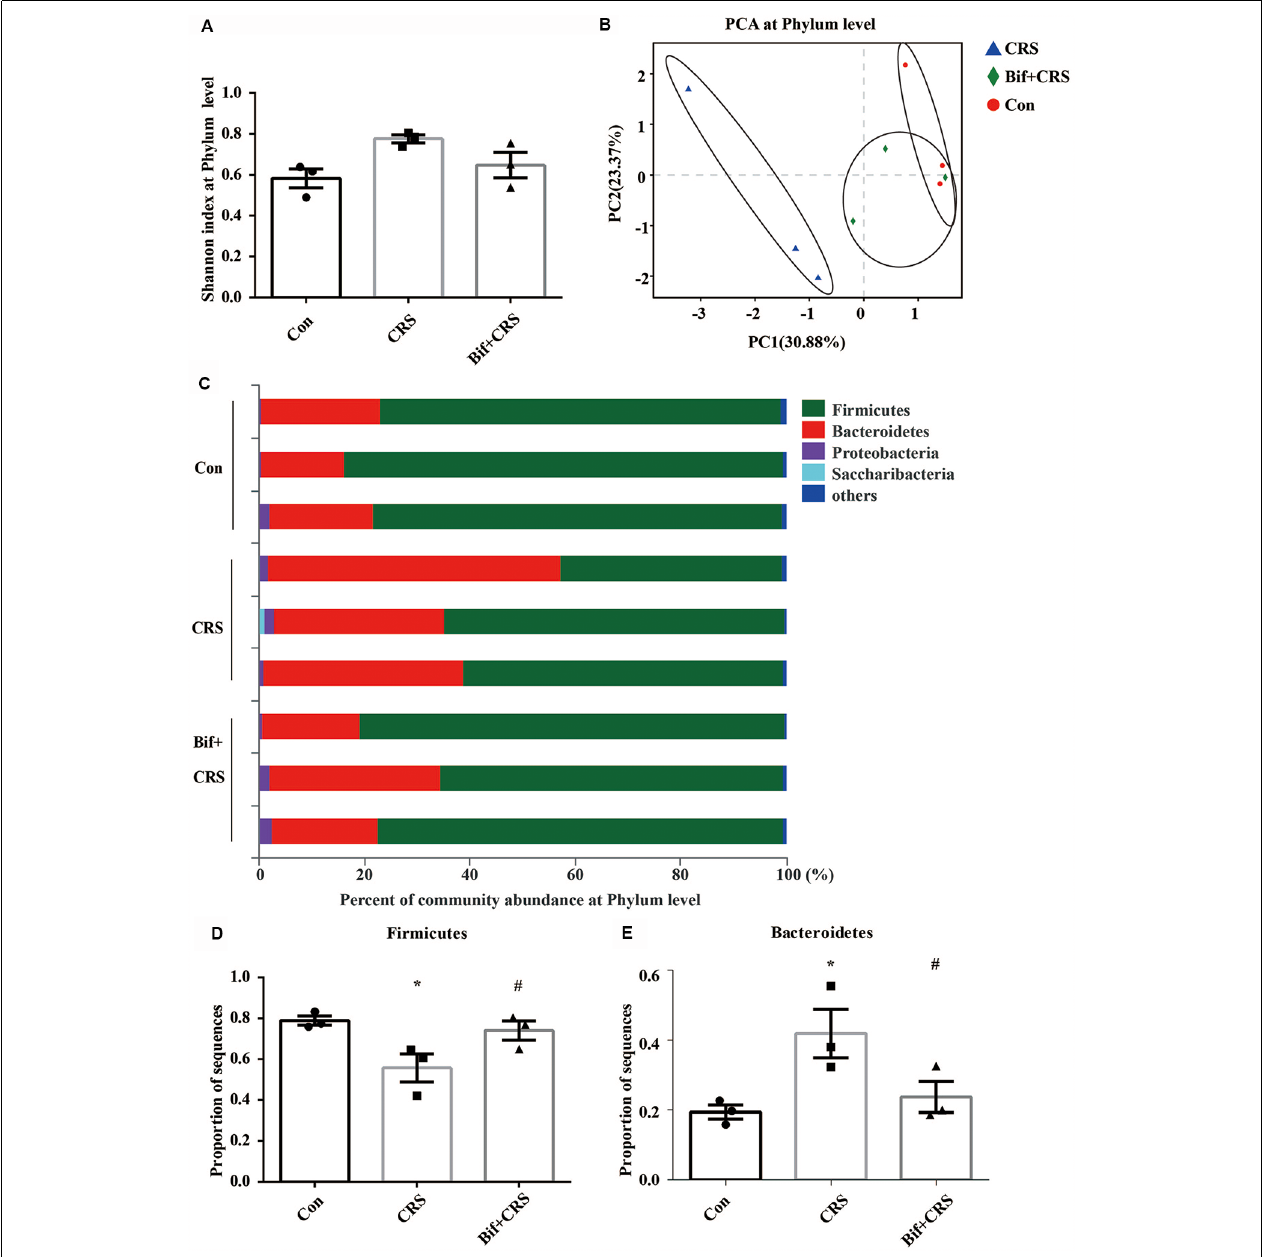
FIGURE 3 | B. adolescentis reversed the imbalance of the intestinal microflora induced by CRS at the phylum level. The mice in the Con, CRS, and Bif+CRS groups were given 10 mL/kg distilled water, 10 mL/kg distilled water, and 0.25 × 10 9 CFU/kg B. adolescentis , respectively, by gavage for 21 days. (A) There was no significant difference in the Shannon index at the phylum level induced by B. adolescentis . (B) The principal component analysis (PCA) results showed no significant difference in the microbial community composition. (C) Community barplot analysis showed the community composition and species abundance in the three groups. (D) The decrease in Firmicutes abundance in the CRS group was enhanced by B. adolescentis . (E) The increased Bacteroidetes abundance in the CRS group was decreased by B. adolescentis . The data are shown as the mean ± SEM. One-way ANOVA followed by the Student-Newman-Keuls test was used. ∗ p < 0.05 vs. the control; # p < 0.05 vs. the CRS group; n = 3 per group. Con, Control; CRS, chronic restraint stress; Bif+CRS, B. adolescentis + chronic restraint stress.